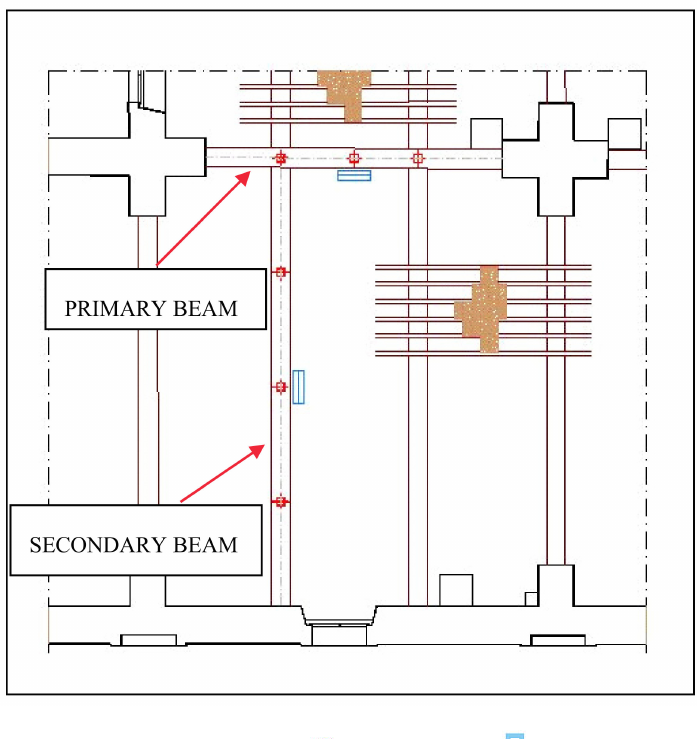
Figure 13. Measurement points: vibrometer and fibre Bragg